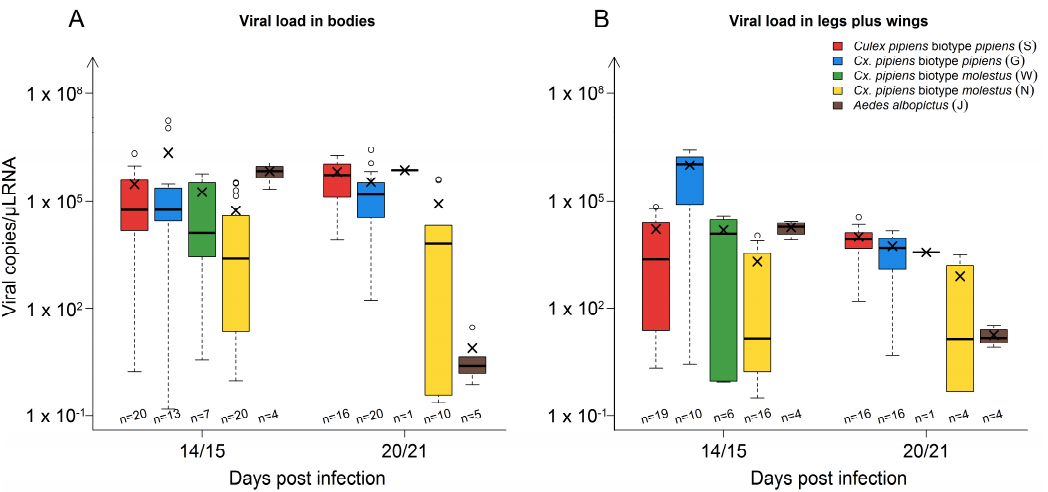
Figure 2. Viral load in mosquito bodies ( A ) and legs plus wings ( B ) 14 / 15 and 20 / 21 days post infection in the different strains: Culex pipiens biotype pipiens , Cx. pipiens biotype molestus , and Aedes albopictus . The horizontal black lines represent the medians, the black ×’s the means, the boxes show the interquartile ranges, and the whiskers the minimum and maximum values. Data falling outside the interquartile ranges are plotted as outliers (o). The number of samples tested per species/time point are indicated above the x-axis.